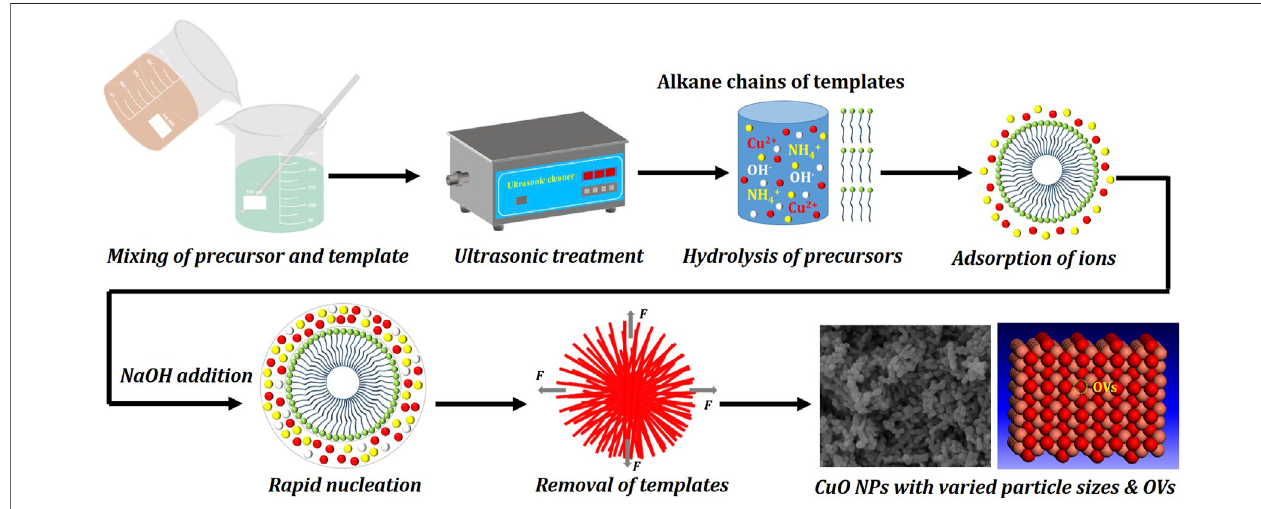
FIGURE 8 | An illustration of the correlation of template effect to particle size and oxygen vacancy defect.